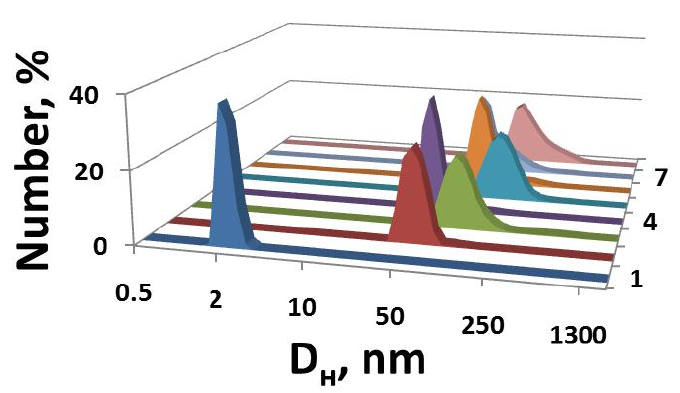
Figure 6. Number-averaged size distribution for the IA-12/oNu binary system at various am- phiphile/oNu molar ratios: 1—individual oNu, 2—0.02, 3—0.045, 4—0.094, 5—0.194, 6—0.394, 7—0.79, 8—1.2; 9—3.9; 25 °C.